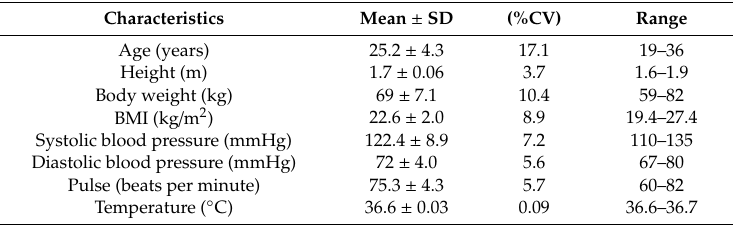
Table 1. Baseline vital signs and demographic data of the 36 male subjects who participated in the study.